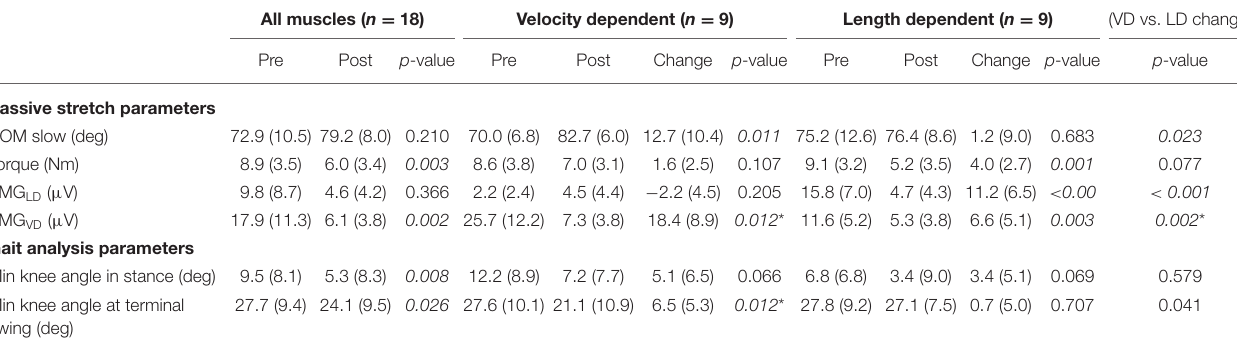
TABLE 4 | Average and standard deviation values of parameters from the instrumented assessment during passive stretch and from the knee gait kinematics in the sagittal plane during gait pre- and post-treatment. All muscles ( n =